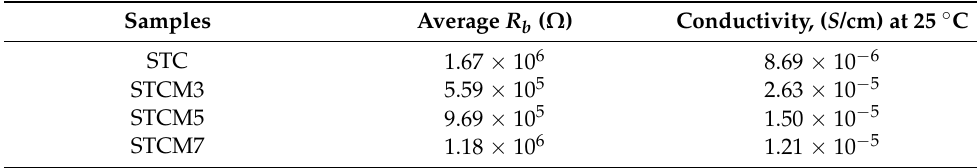
Table 3. The conductivity values of the STC and STCM materials.